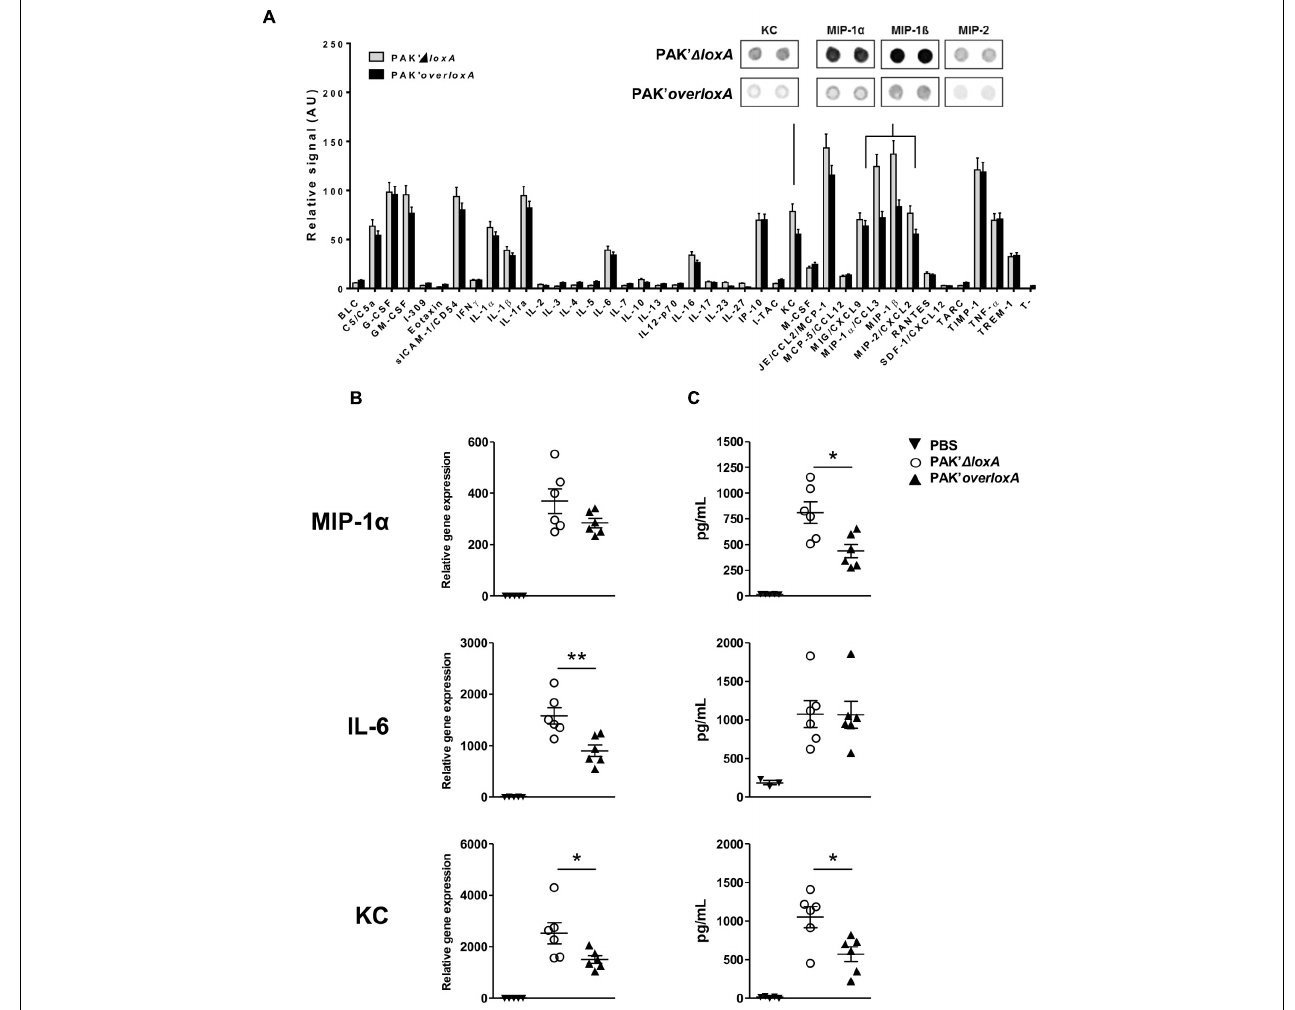
FIGURE 3 | Pseudomonas aeruginosa LoxA secretion modulates the mucosal immune response. (A) Semi-quantitative representation of the levels of 40 cytokines in BALF of either PAK’ (cid:49) loxA -infected- or PAK’ overloxA -infected mice, 24 h post-infection. The data were normalized to internal positive controls spotted on the same protein array membrane and are expressed as relative units. The most relevant cytokine-array spots (KC, MIP-1 α , MIP-1 β , and MIP-2) are shown. (B) Quantitative RT-PCR analysis of IL-6, KC and MIP-1 α mRNA transcripts extracted from the corresponding lungs tissues. (C) Concentrations of IL-6, KC and MIP-1 α in the same BALF as in (A) were determined by ELISA and are represented as the mean ± SEM ( n = 5–6 mice/group). Data are representative of three independent experiments ∗ p < 0.05, ∗∗ p < 0.01.